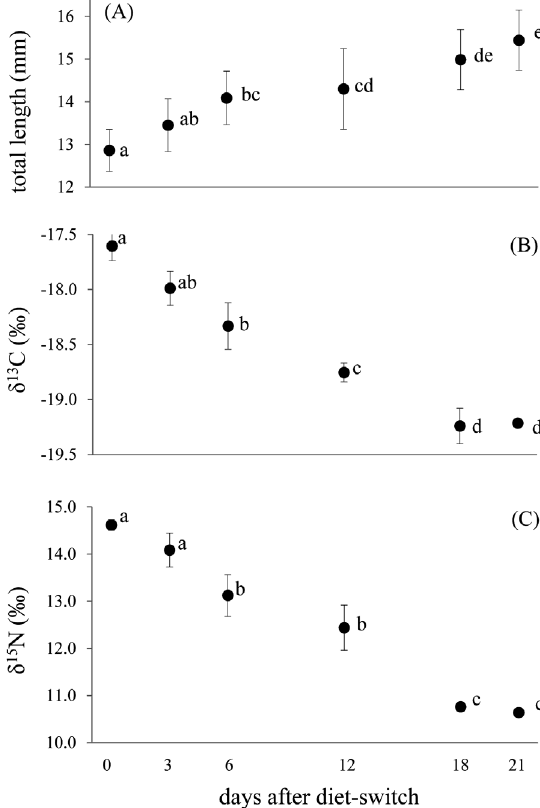
Fig. 2. Trajectories of total length (A), d 13 C (B) and d 15 N (C) in leptocephali after diet-switch. Analysis of variance with Tukey-test was performed, and mean values carrying different alphabets differ signi fi cantly ( P <